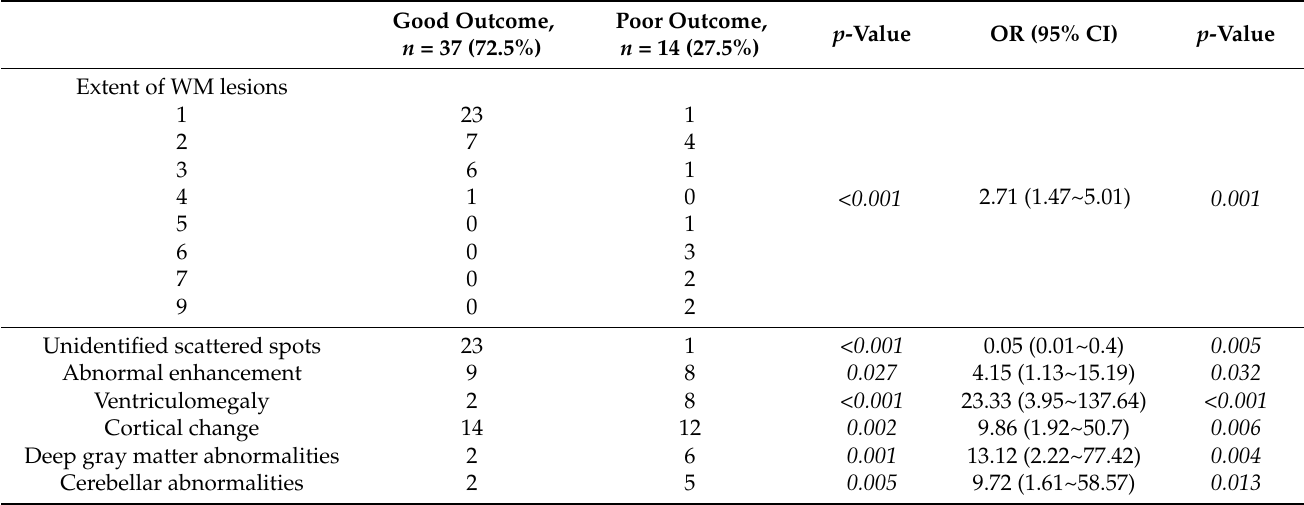
Table 5. MRI findings according to neurologic